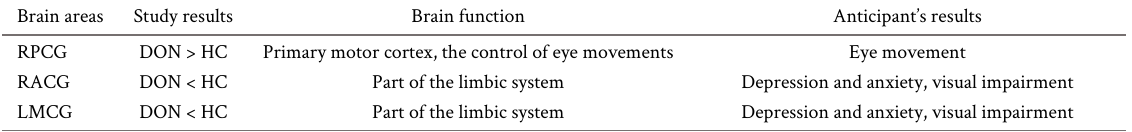
Table 4. fALFF changes in brain areas of DON patients and its potential